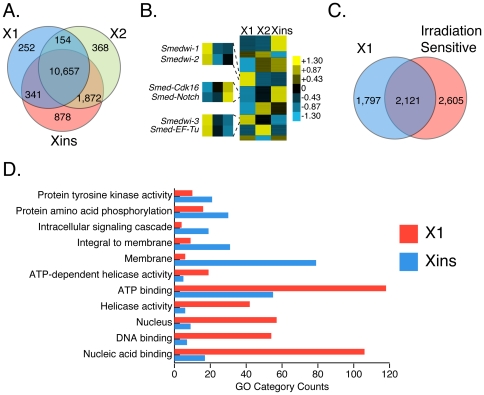
Transcript expression profile of S. mediterranea neoblasts.(A) Overlap in transcript expression between the X1 (blue), X2 (green) and Xins (red) cell populations displayed as Venn Diagrams. (B) Expression values (FPKM) for transcripts in the X1 (column 1), X2 (column 2) and Xins (column 3) cell populations (expressed as Z-scores) are shown in the heat map. Z-score colors range from yellow (above the mean) and blue (below the mean). (C) Overlap in expression between transcripts enriched in FACS generated X1 cells and transcripts classified as irradiation-sensitive in sexual and asexual strains. (D) GO category counts (x-axis) for 11 categories (y-axis) associated with transcripts enriched in X1 (blue) and Xins (red) cells. Category counts are signficantly different between X1 and Xins populations for all categories (p<0.0009; Chi-square). P-values were adjusted using the Bonferroni correction.